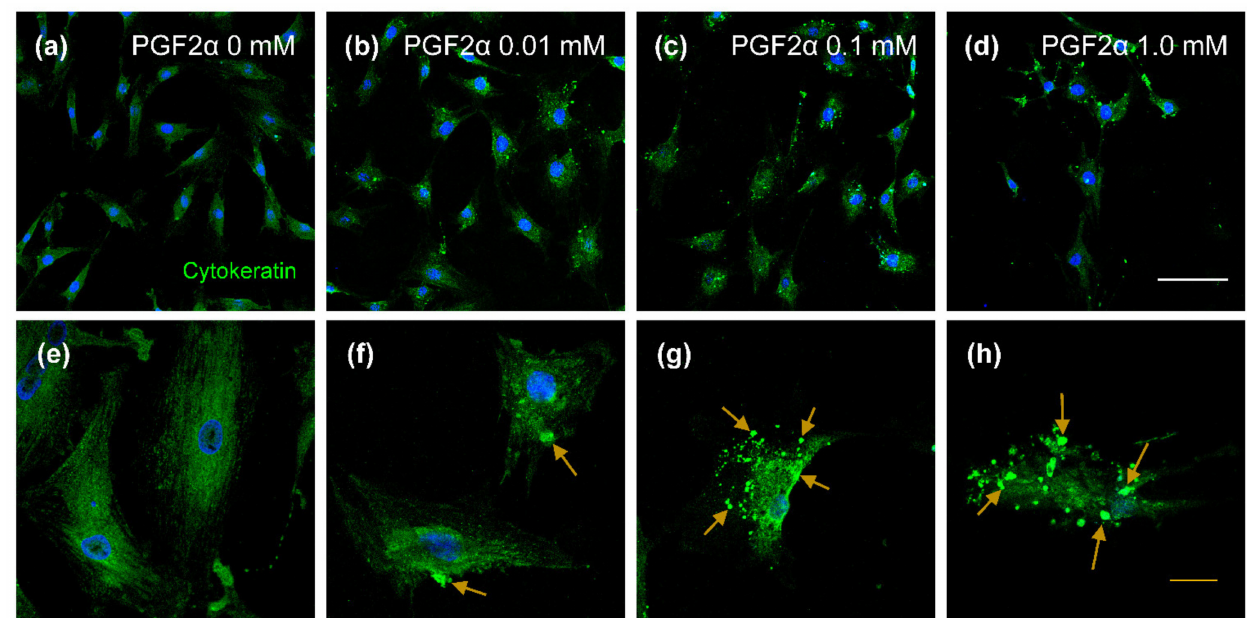
Figure 4. Confocal laser scanning microscope image of cytokeratin protein in prostaglandin F2 alpha (PGF2 α )-induced bovine luteal thecal cells (LTCs). The LTCs were incubated in culture media supplemented 0 mM ( a , e ), 0.01 mM ( b , f ), 0.1 mM ( c , g ), and 1.0 mM ( d , h ) PGF2 α . Green: cytokeratin protein, blue: nucleus, yellow arrows: damaged cytokeratin, white line: 50 µ m, yellow line: 20 µ m.